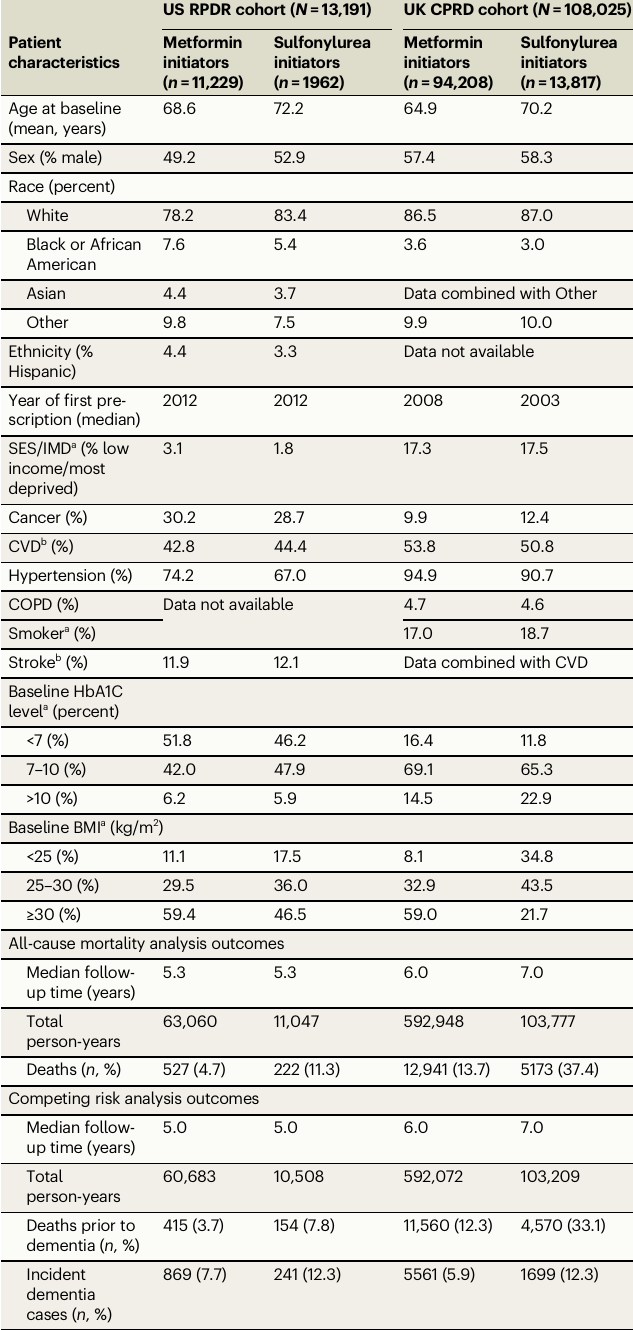
BMI bodymassindex, COPD chronicobstructive pulmonary disease, CVD cardio-vascular dis- ease, HbA1C glycosylated hemoglobin. IMD Index ofMultipleDeprivation(of fi cial measure of relative deprivation bysmallgeographic regionin theUK). a SES (US RPDR) and IMD (UK CPRD)aredistinct,country-speci fi c socioeconomicindicators, intended forcomparison within — ratherthan across — the two cohorts.IMD,smoking status, HbA1C, and BMI had 7%, 2%, 21%,and 3% ofmissing values inthe UKCPRD, respectively.The corresponding statistics presentedinthe table arevalid percentages out ofpatients without missing information. b Stroke andCVD indicators were